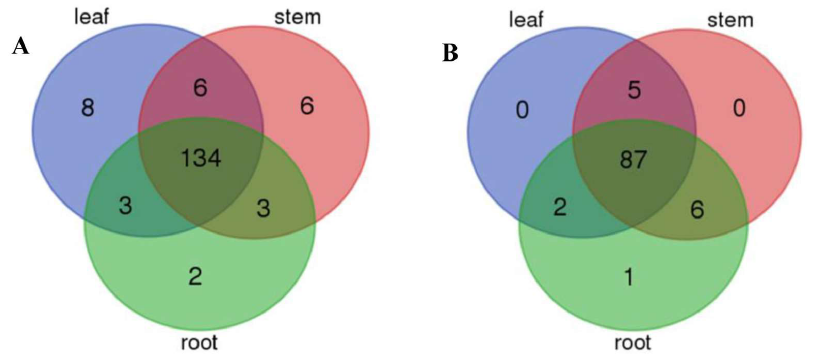
Figure 2. Venn diagram of the miRNAs identified in leaves, stems and roots of P. euphratica . Counts are based on unique sequences, and Venn diagrams of ( A ) known miRNAs and ( B ) novel miRNAs found in the different tissues. Table 3. Novel miRNA especially detected in stems and roots of P. euphratica (not detected in leaves).